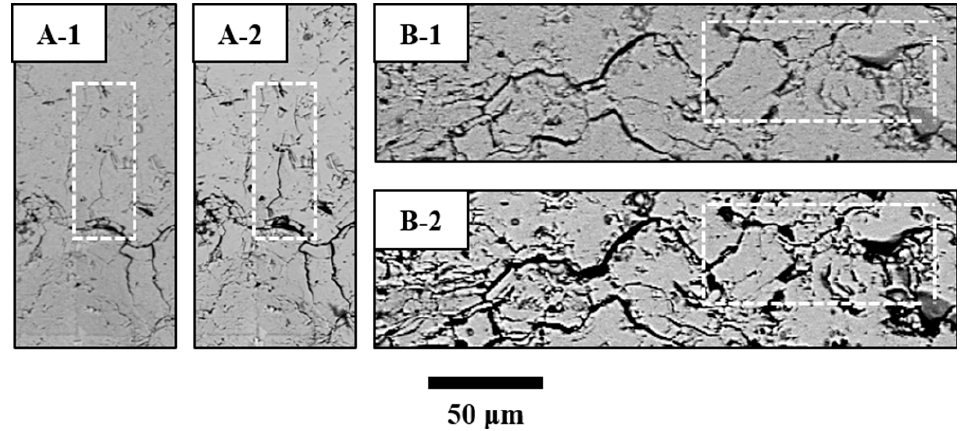
Figure 6. Crack-growth behavior on the cross section during CTF tests: ( A ) vertical crack and ( B ) horizontal crack. Each number indicates crack images: ( 1 ) before test and ( 2 ) after 320 cycles.